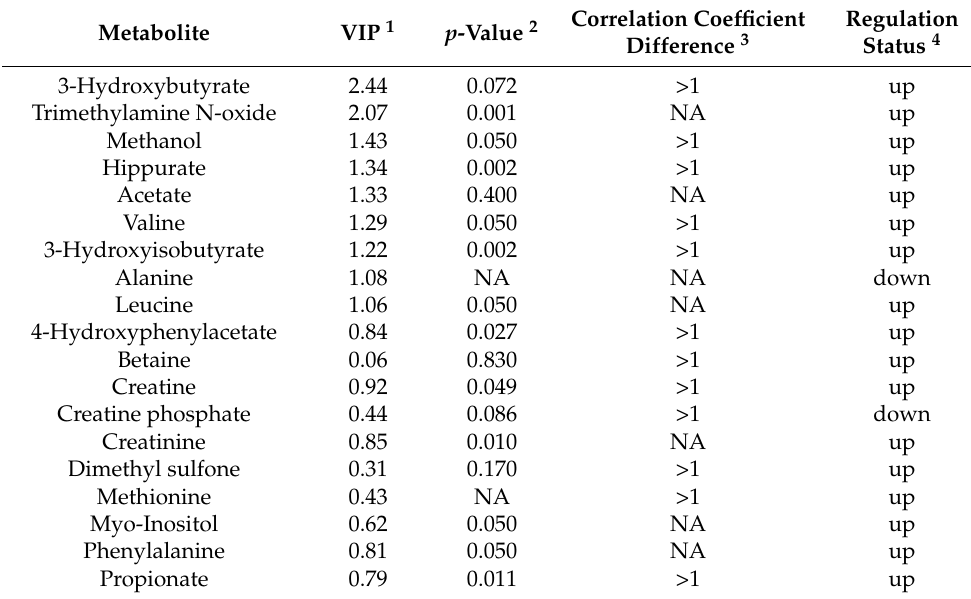
Table 2. Metabolites changed in serum of Sanhe cattle after acute cold stress.